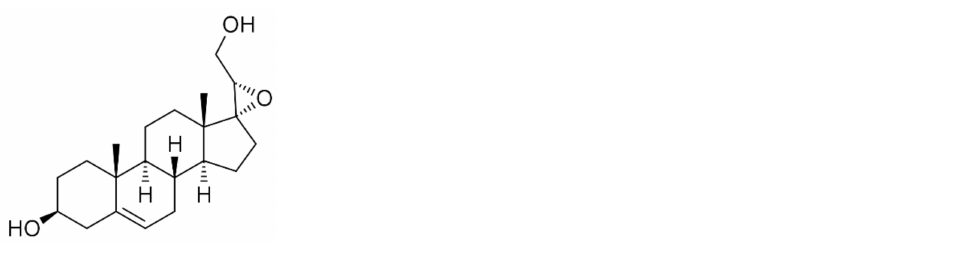
Figure 1. Chemical structure of 17alpha, 20R-epoxypregn-5-ene-3 β , 21-diol